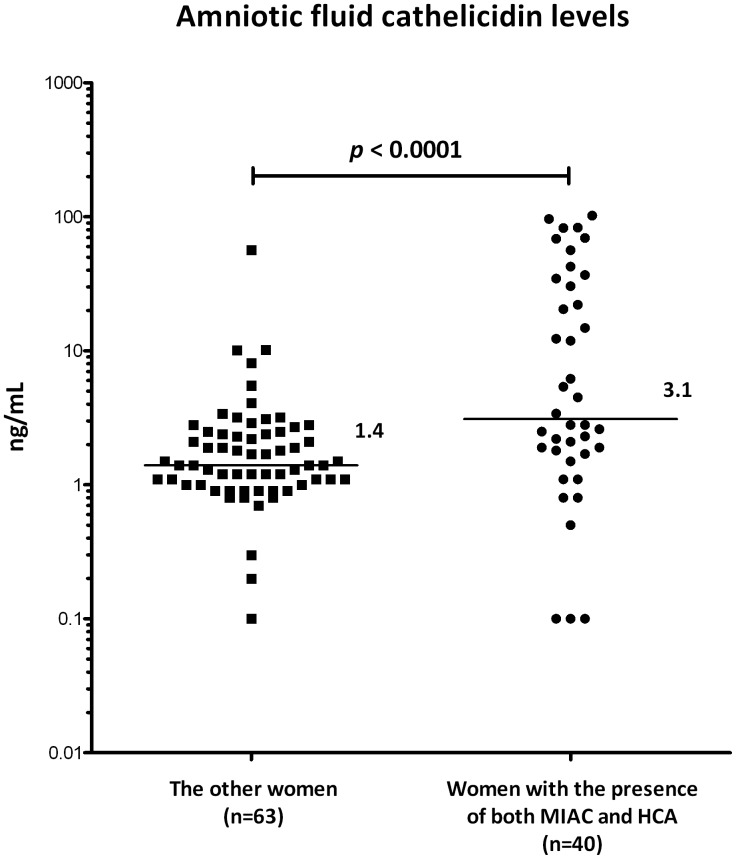
Validation of amniotic fluid cathelicidin levels on independent prospective replication cohort.Amniotic fluid cathelicidin levels in PPROM women with MIAC and HCA were compared with those in whom at least one condition was ruled out. The latter group involved women with neither MIAC nor HCA, without MIAC but with HCA, or with MIAC but without HCA. In line with the validation experiment, amniotic fluid cathelicidin concentrations were significantly higher in women with confirmed MIAC and HCA than in the other women. Cathelicidin levels were measured using a commercial ELISA kit. Values were evaluated using nonparametric Mann-Whitney U test. Graph represents individual values, horizontal bars indicate median values. Abbreviations are explained in the Fig. 2.